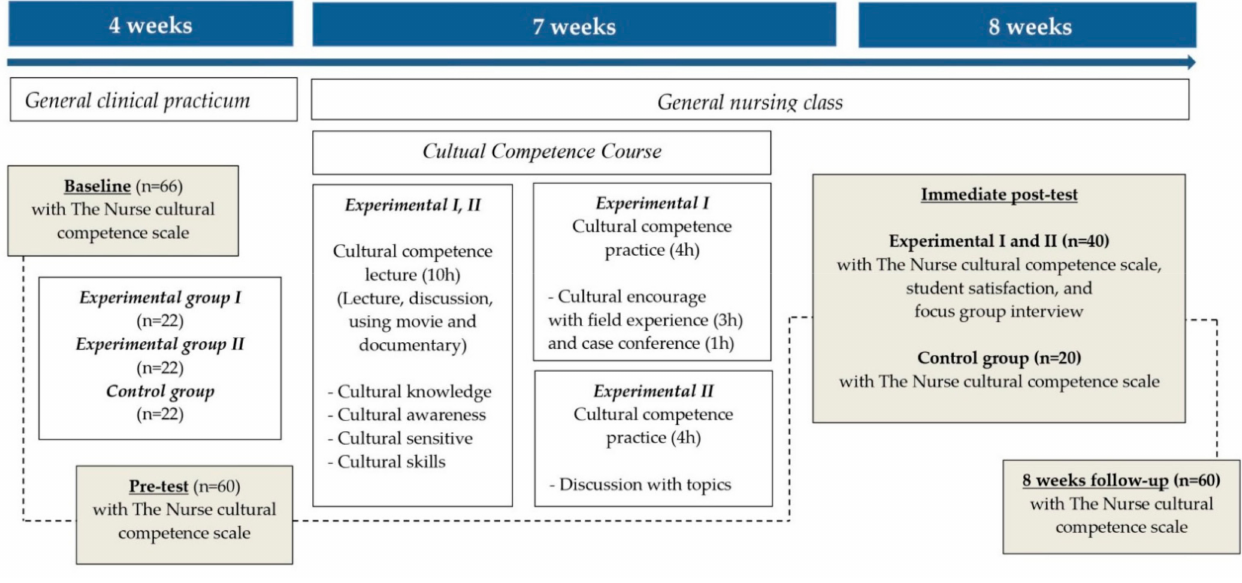
Figure 1. Study flow